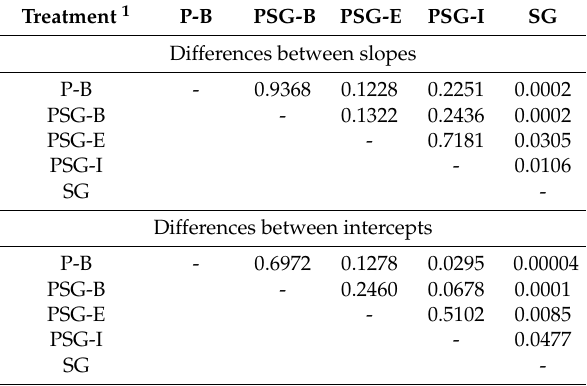
1 P = pine, SG = flat planted switchgrass, and PSG = pine intercropped with switchgrass. Additional treatment